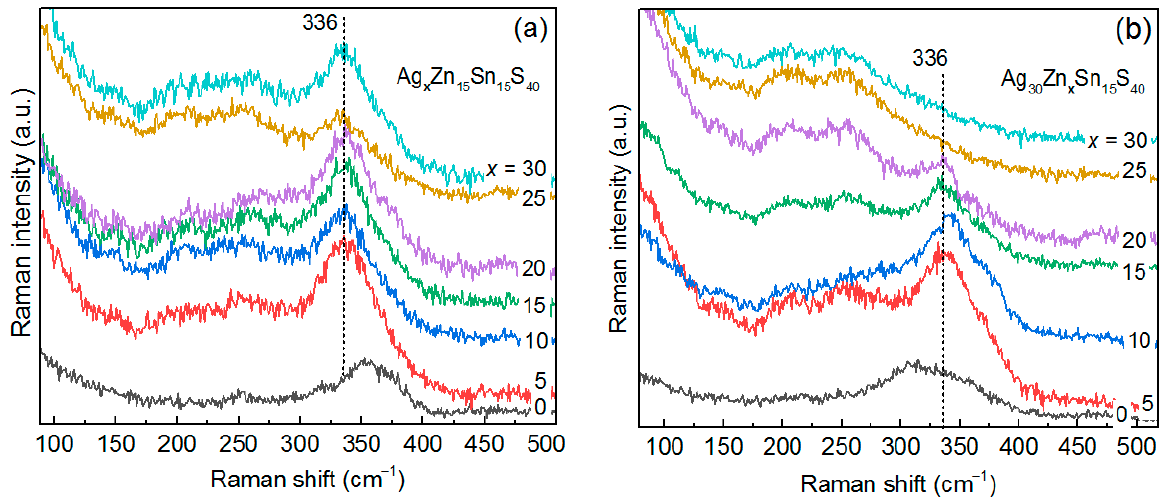
Figure 4. Raman spectra ( λ exc = 514.7 nm) of a series of AZTS NCs with a varied nominal content of Ag ( a ) and Zn ( b ). The spectrum at x Ag = 0 coincides with the Zn-Sn-S NC spectrum reported by us for the first time recently [29]. With an increase of the nominal Ag content in AZTS NCs, the features at 210 and 260 cm − 1 increase in intensity with respect to the 336 cm − 1 one. Note that according to XPS data, with an increase of the nominal Ag content, the real Zn content decreases from 37 to 23% and the Sn content is constant and low (<5%) (Figure 5a).